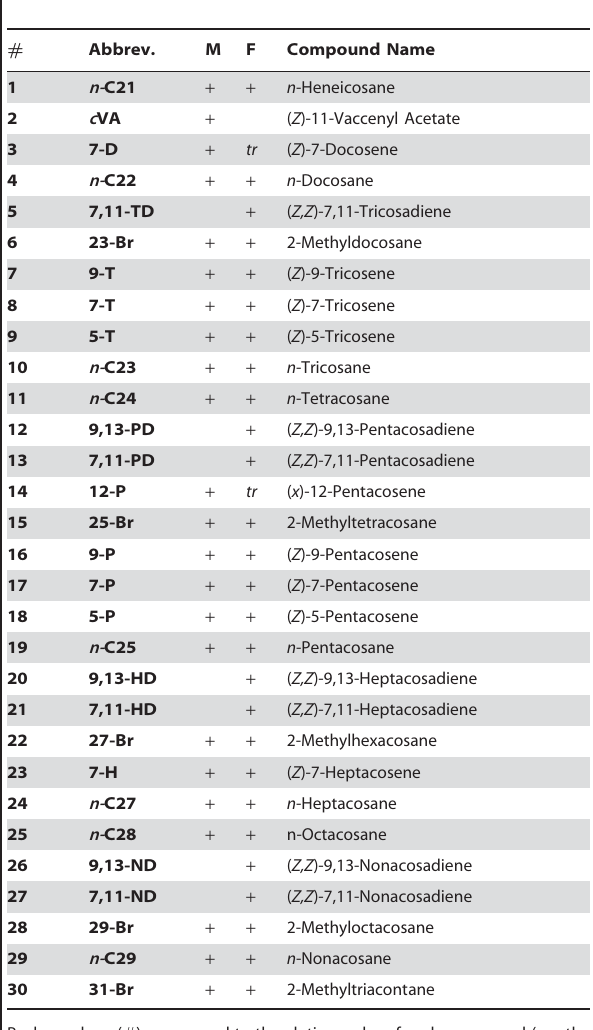
Table 1. Major compounds detected in whole-body extracts of D. melanogaster